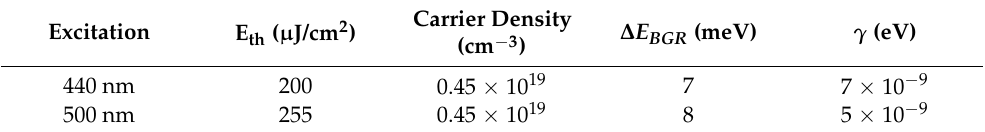
Table 1. A summary of the important parameters mentioned in the manuscript.